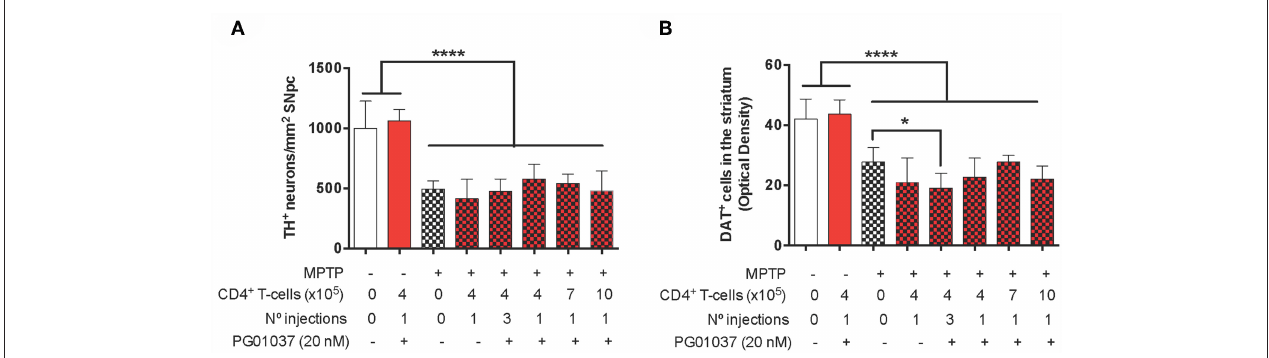
FIGURE 4 | Evaluation of the therapeutic potential at the level of neurodegeneration of DRD3 inhibition in CD4 + T-cells by treatment with a selective antagonist ex vivo in MPTPp-treated mice. CD4 + T-cells (4 × 10 5 , 7 × 10 5 , or 10 × 10 5 per mouse) were treated with or without PG01037 (20nM) and then i.v. injected in experimental animals 1 day after the first MPTPp injection (see Figure 2A ). In some cases, animals received 3 injections of CD4 + T-cells separated by 1 week intervals. Neurodegeneration was analysed 1 week after the last MPTPp injection. Dopaminergic neurons were quantified by immunohistochemical analysis of tyrosine hydroxylase (TH) in the substantia nigra pars compacta (SNpc) (A) and dopamine transporter (DAT) in the striatum (B) . Data represent the mean with the SEM. One-way ANOVA followed by Tukey’s multiple comparison post-hoc test was used to determine statistical differences: * p < 0.05; **** p < 0.0001; n = 5–8 mice per